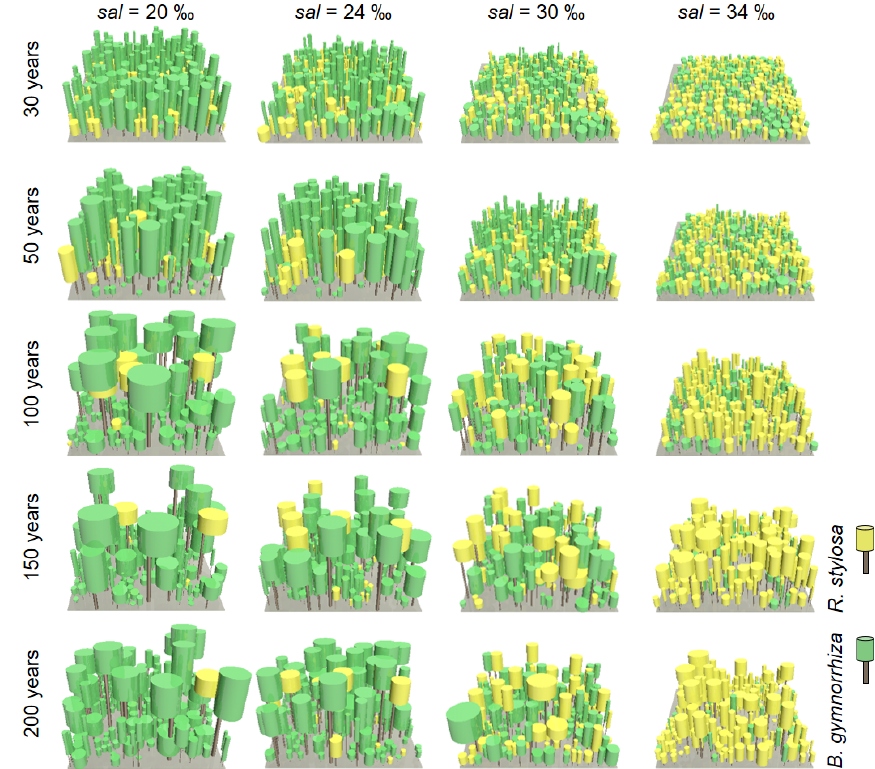
Figure 6. Visualization of forest structures over 200 years under different soil salinity (sal), 20‰, 24‰, 30‰, and 34‰, taken from one of the ensemble simulations. The brown-colored objects represent the stem while the yellow- and green-colored objects represent the crowns of R. stylosa and B. gymnorrhiza , respectively. The forest floor shown is the 30m × 30m wide computational domain.